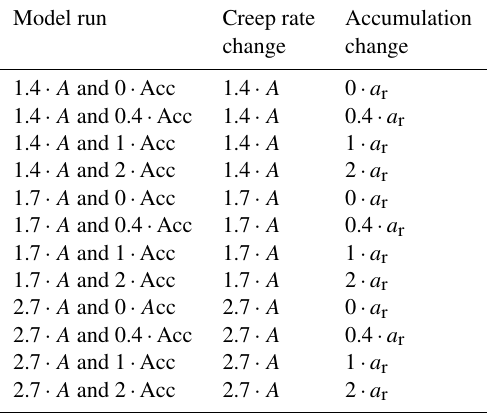
Table 6. All combined experiments. The creep rate change is im- plemented by increasing the rate factor A (Eq. 6) and the change in material accumulation by varying the accumulation rate a r (Eq.